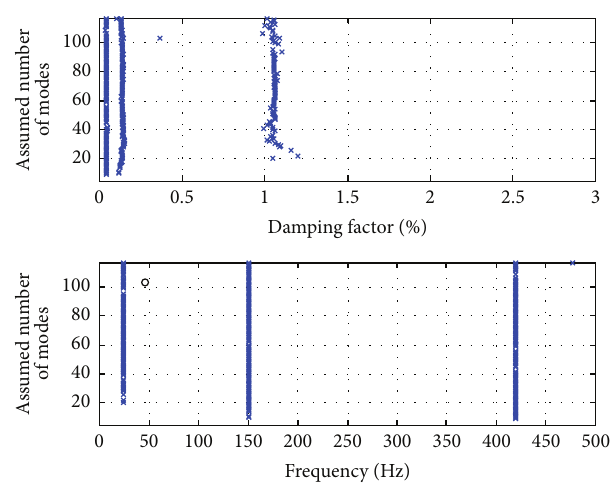
Figure 7: Stabilization diagram on eigenfrequencies and damping factors for the clamped beam using shifting properties of the block observability matrix.